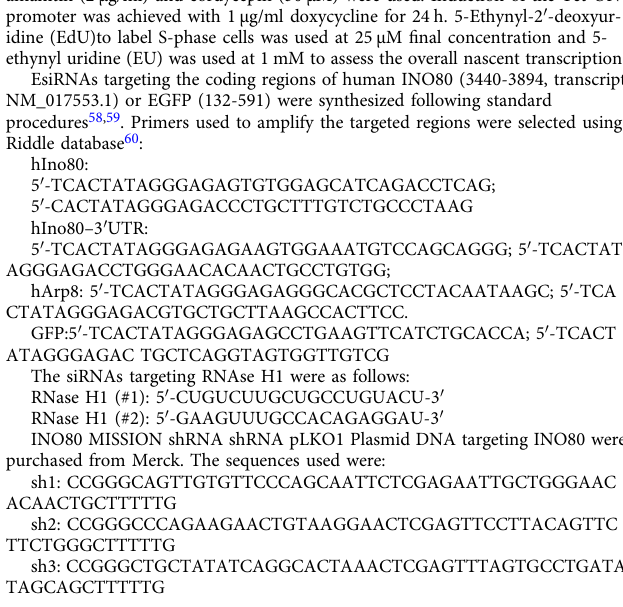
Fig. 7 Dynamic R-loop turnover at the LacO locus by INO80 tethering. a Schematic representation of the experimental assay. LacI-eGFP tagged INO80E or RNHseH1 were transfected into U2OS cells harbouring a 256xLacO array. Immunostaining with S9.6 after 24 h allows visualization of R-Loops at the LacO locus. b Representative immunostained images of LacO cells transfected with eGFP-LacI, eGFP-LacI- INO80E, eGFP-LacI-RNHaseH1. Scale bar is 10 µ m. N = 4 biological replicates were performed with similar results c Boxplot showing the S9.6 signal intensity relative to the underlying eGFP-LacI- tagged proteins intensity at the LacO locus in the respective conditions, as described in a . Plot shown is min to max values with line at median. Number of cells per condition shown: eGFP = 97; RNase H1 = 116; INO80E = 100. N = 3 experiments ****adjusted p -value < 0.0001; one way ANOVA test. d Schematic representation of the experimental assay. LacO-carrying U2OS cells were co-transfected with RBD-DsRed and either LacI-eGFP or LacI-eGFP- INO80E plasmids and live cell imaging carried out in Z stacks imaged every 6 min. e Representative live images of LacO cells transfected with LacI-eGFP or LacI-eGFP-INO80E n = 3 biological replicates gave similar results. Scale bar is 10 µ m. f Images of selected time-points are shown from a representative live imaging experiment. Merge shows LacO co-localisation with LacI-eGFP or LacI-INO80E cell during 48 min of the time course analysis for RBD-DsRed and LacI-tagged proteins. Merged images of whole cells are in Supplementary Figure 11d. Montage is a zoom of the LacO site from the representative cell in e . g Upper panel: formula for calculating Fold-Change in Intensity (FC-I). Intensity change of the RBD-DsRed signal normalized over the underlying eGFP signal at the locus was measured at 6-minute intervals throughout the course of the experiment for a total of 1500 min. FC-I was calculated as the normalized RBD-DsRed signal at each timepoint relative to the previous timepoint. Lower panel: Total, negative and positive FC-I(log2) values for RBD- DsRed signal in LacI-eGFP and LacI-INO80E cells. The total number of FC-I(log2) values was approximately 900 for both LacI-eGFP and LacI-INO80E. Positive FC-I(log2) values are 70 – 75% of the total. Negative FC-I(log2) are 25-30% of the total. N = 5 independent live cells quanti fi ed for each condition. ****adjusted p -value < 0.0001; ANOVA with Kruskal –